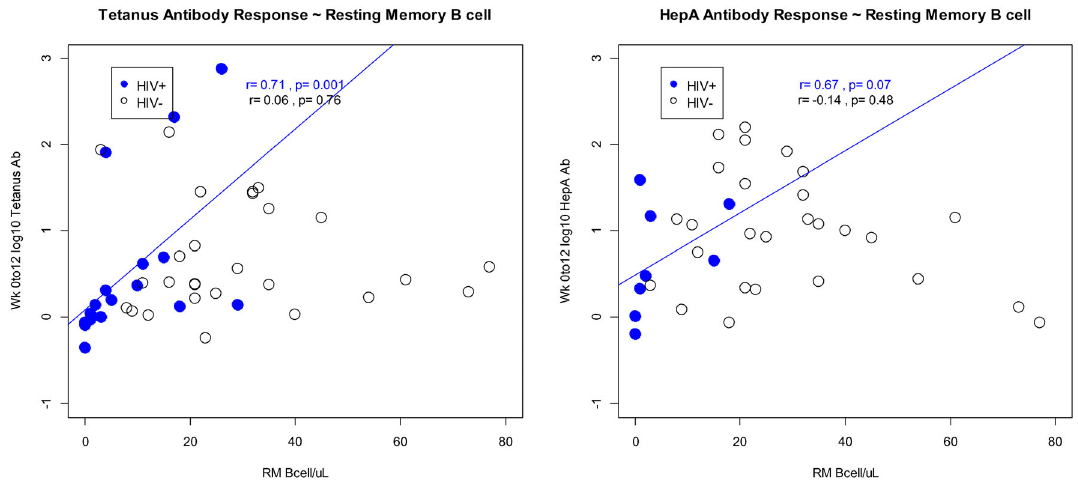
Figure 3. Correlations between antibody responses to vaccines and resting memory count at baseline in HIV infected and uninfected controls. a. Tetanus vaccine b. Hepatitis A